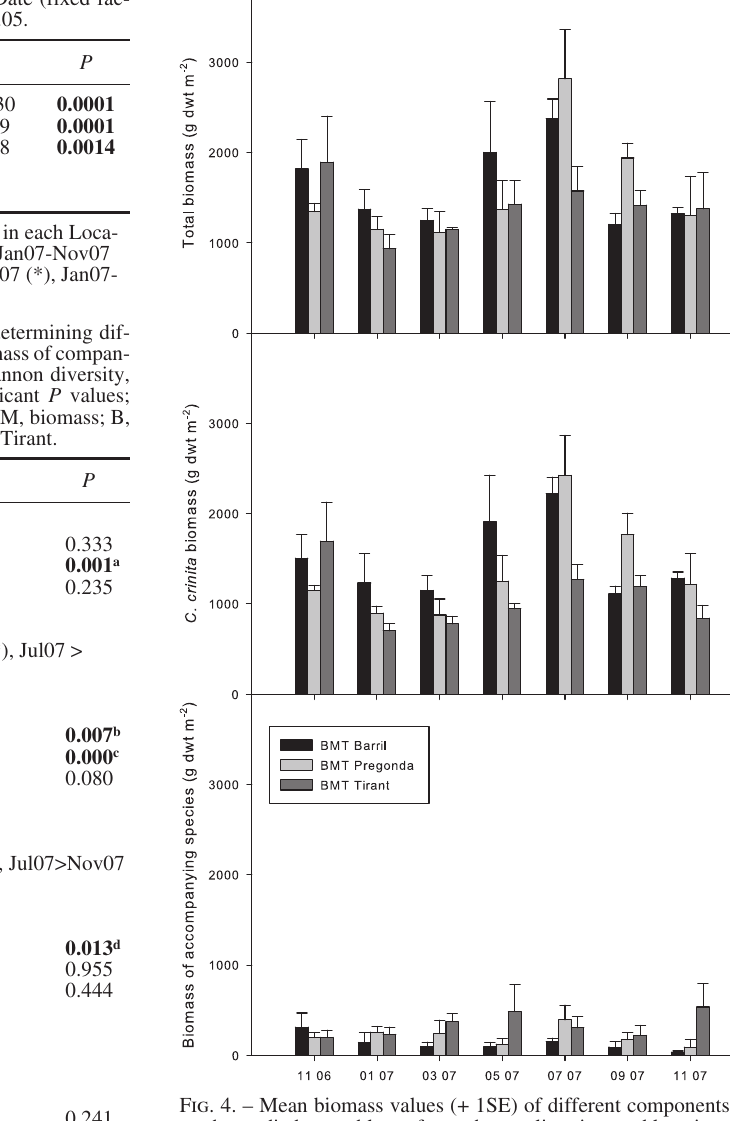
Fig . 4. – Mean biomass values (+ 1SE) of different components of the studied assemblages for each sampling time and